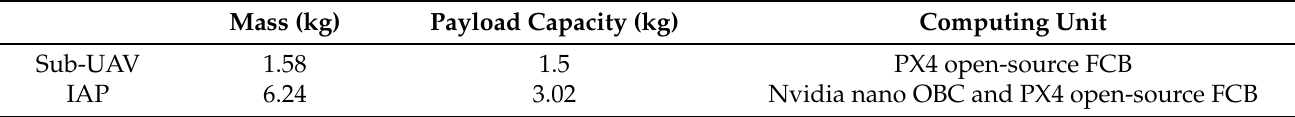
Table 1. Relevant physical parameters of the sub-UAVs and IAP prototype.